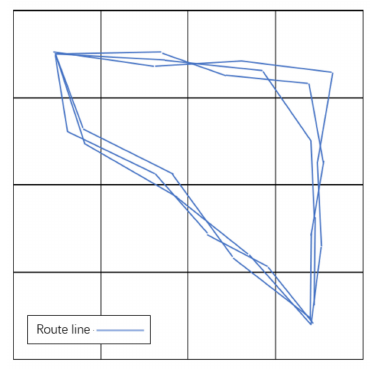
Figure 4. Dot connection diagram